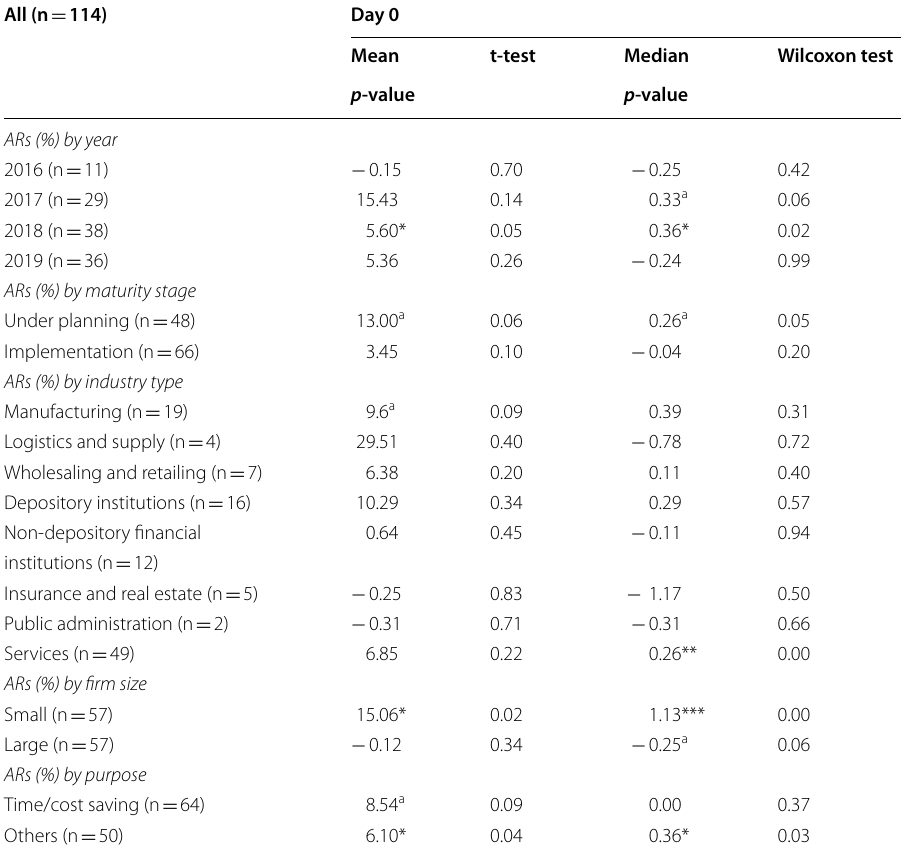
Table 4 Subgroup analysis